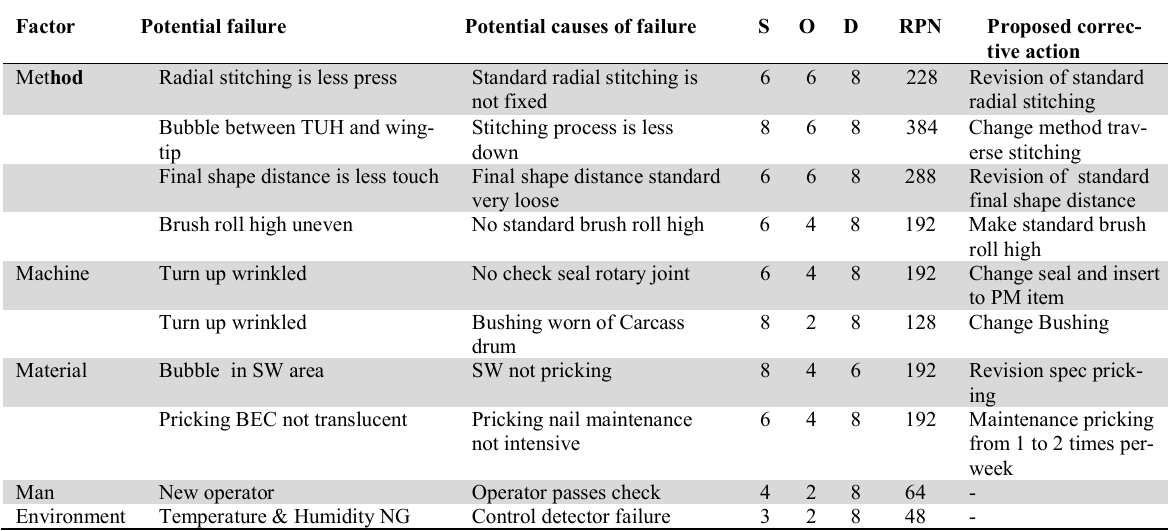
Calculation of FMEA BLP defective products